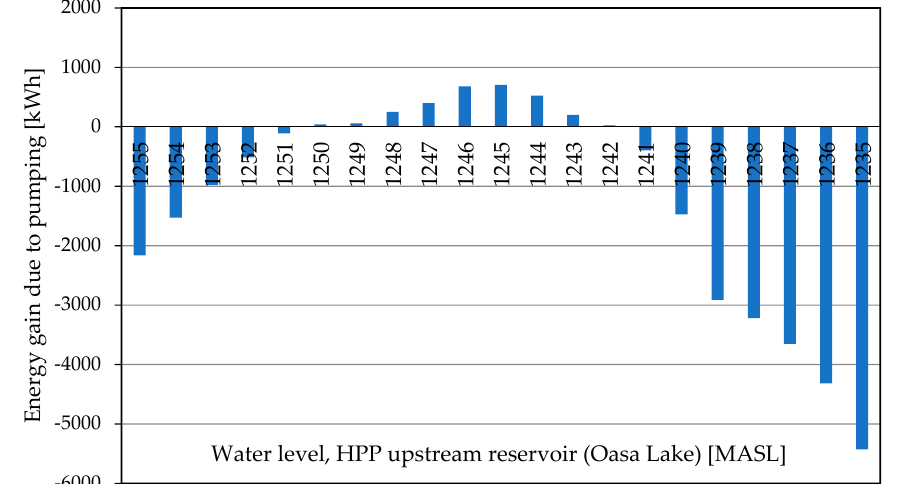
Figure 7. Energy gain [kWh] due to pumping for various levels in the HPP upstream